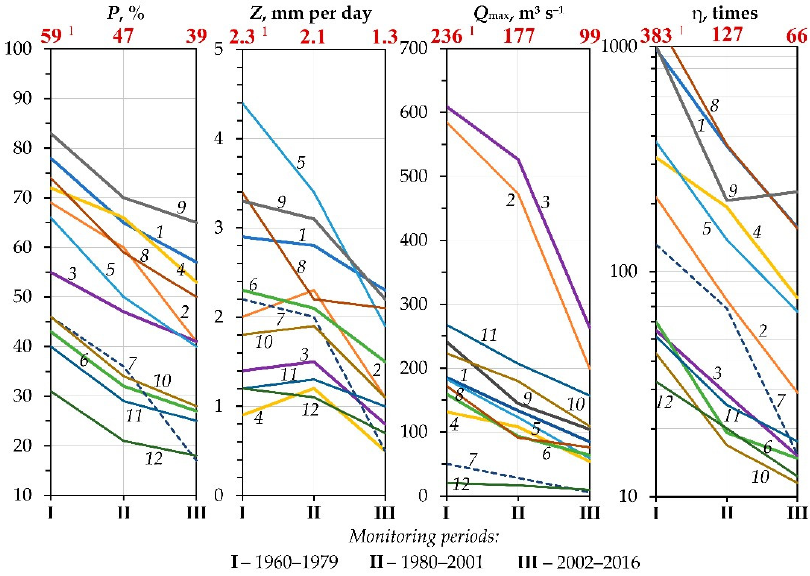
Figure 11. Changes in intra-annual distribution characteristics of water flow recorded in some studied rivers of the Middle Volga region (the Chuvash Republic, Republic of Tatarstan, Ulyanovsk Oblast, Samara Oblast, and Orenburg Oblast, see Figure 2A), calculated based on data from [65]. P —the portion of spring (snowmelt-induced) flood surface water runoff in the total annual surface water runoff; Z —the average intensity of spring (snowmelt-induced) flood surface water runoff; Q max —maximum (per annum) discharge timed to the spring (snowmelt-induced) flood period; η —the average dimensionless ratio between Q max and minimum (per annum) water discharge timed to the river-ice-free baseflow period ( Q min ): η = Q max / Q min . The rivers: 1 –Aktai at Karavayevo